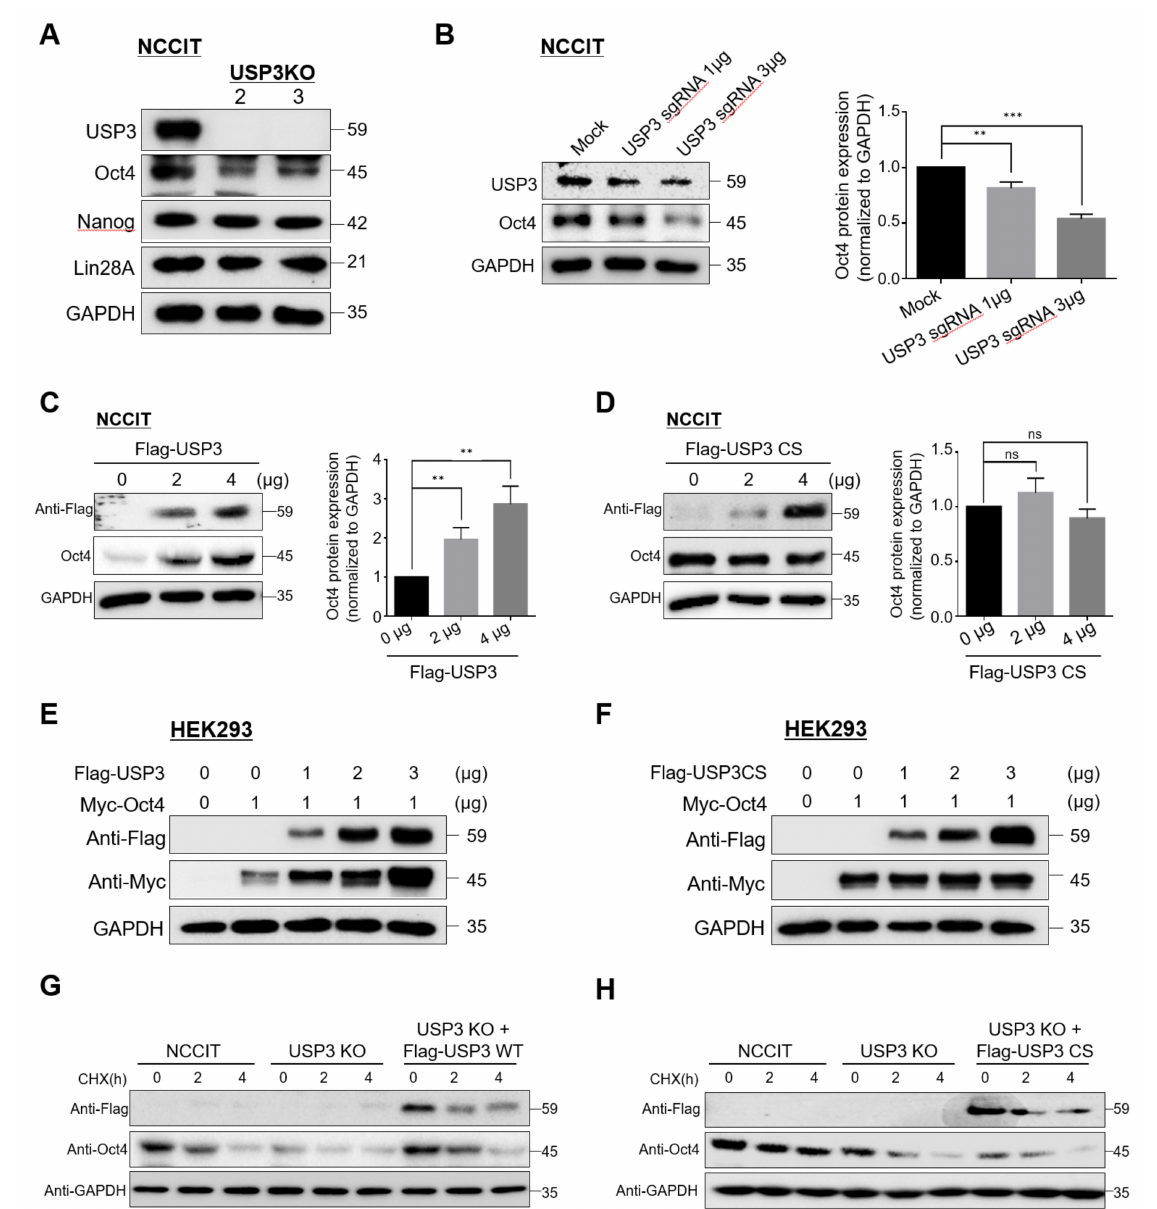
Figure 2. USP3 regulated Oct4 protein stability. ( A ) Protein expression of stem cell transcription factors upon deletion of USP3 in USP3 KO NCCIT clones #2 and #3 were detected by Western blot analysis using the indicated antibodies. GAPDH was used as a loading control. ( B ) NCCIT cells were transfected with constant amount of Cas9 along with increasing concentrations of sgRNA targeting USP3 (1:1 and 1:3 ratios, respectively). Depletion of USP3 and its effect on the endogenous expression of Oct4 protein was detected by Western blot. The band intensities of Oct4 proteins were estimated using ImageJ software and were graphically represented after normalization with GAPDH. Data were presented as the means ± SDs of three independent experiments ( n = 3). Statistical analysis was conducted by Student’s t -test (** p < 0.01, *** p < 0.001). ( C ) NCCIT cells were transfected with increasing concentrations of wild-type Flag-USP3 (0, 2, 4 µ g), and the endogenous expression of Oct4 was analyzed by Western blotting. The band intensity of Oct4 proteins were estimated using ImageJ software and graphically represented after normalization with GAPDH. Data were presented as the means ± SDs of three independent experiments ( n = 3). Statistical analysis was conducted by Student’s t -test (** p < 0.01). ( D ) NCCIT cells were transfected with increasing concentrations of catalytic mutant Flag-USP3CS (0, 2, 4 µ g), and the endogenous expression of Oct4 was analyzed by Western blotting. The band intensities of Oct4 proteins were estimated using